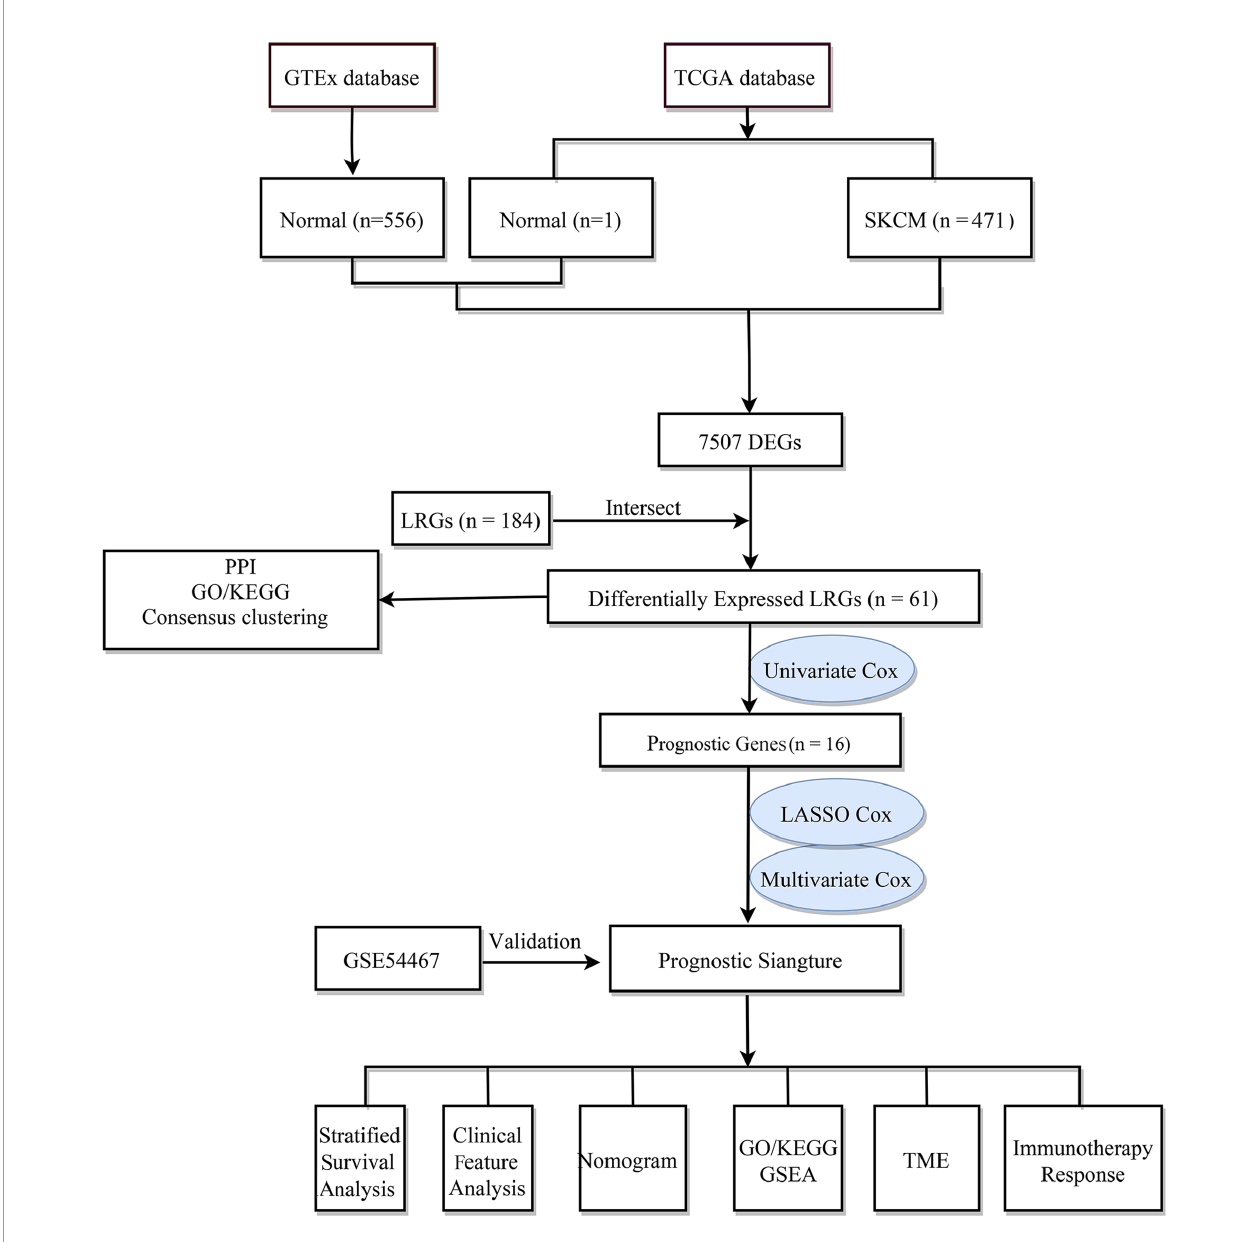
FIGURE 1 | The fl ow chart of the study